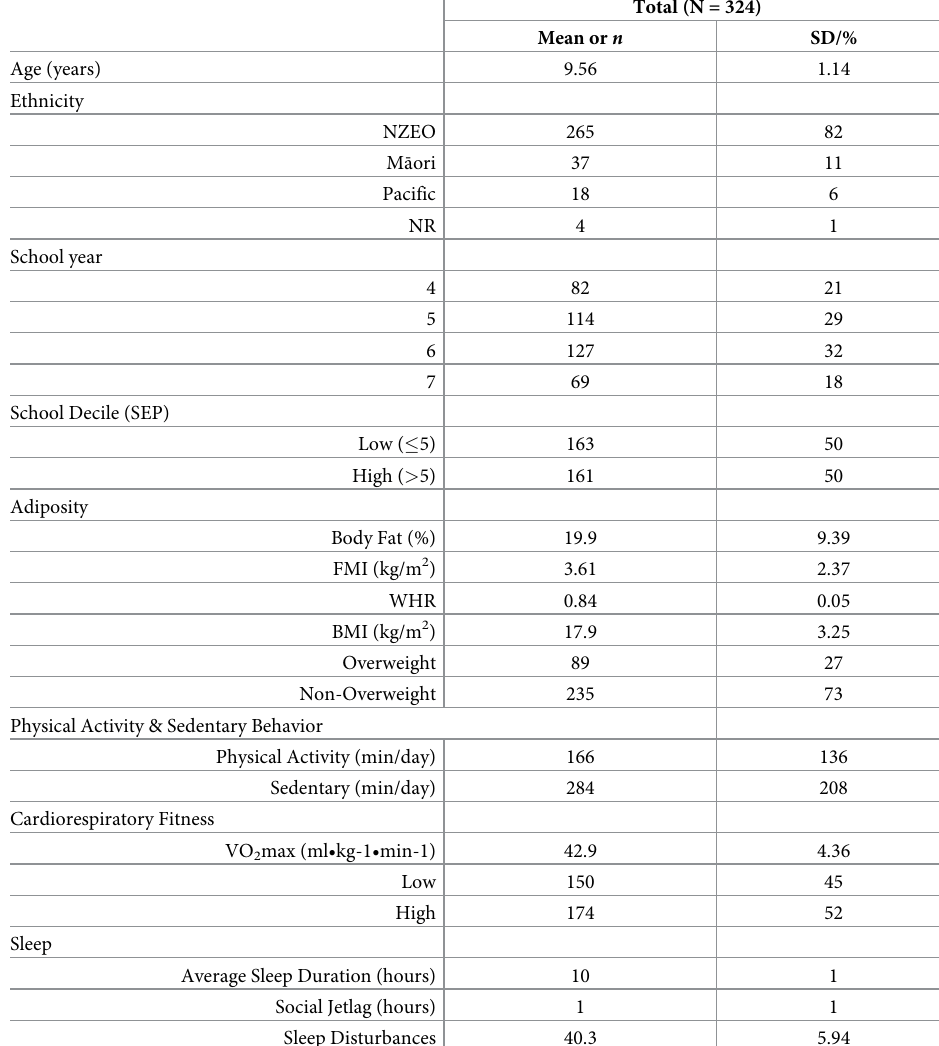
Table 1. Summary of participant